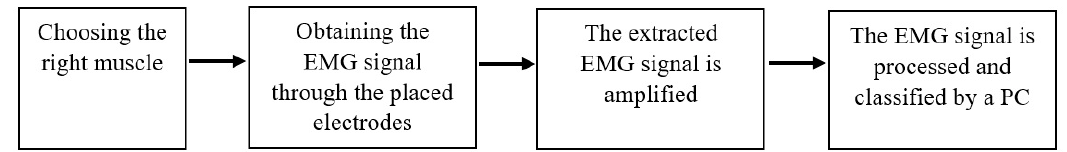
Figure 6. Block diagram of extracting and processing the surface electromyograph (sEMG) signal.